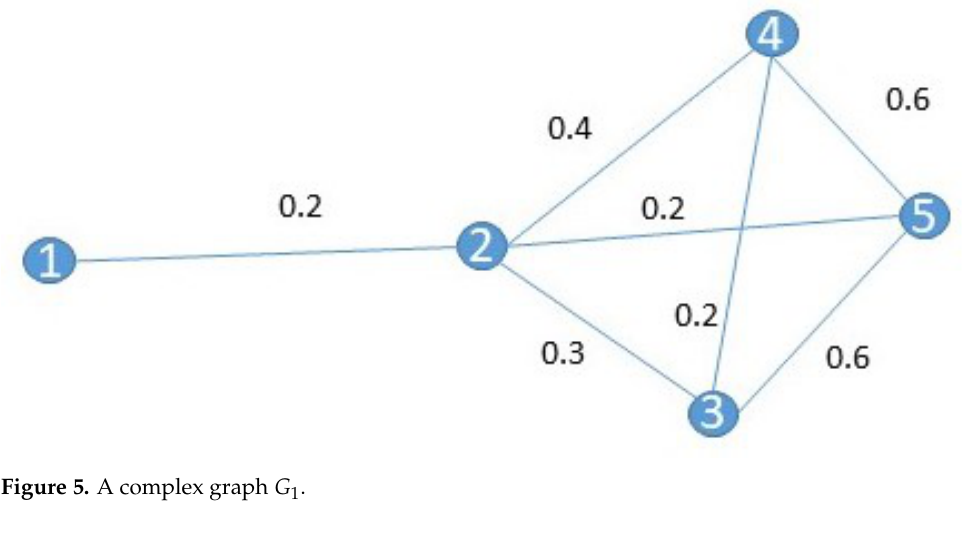
Figure 5. A complex graph G 1